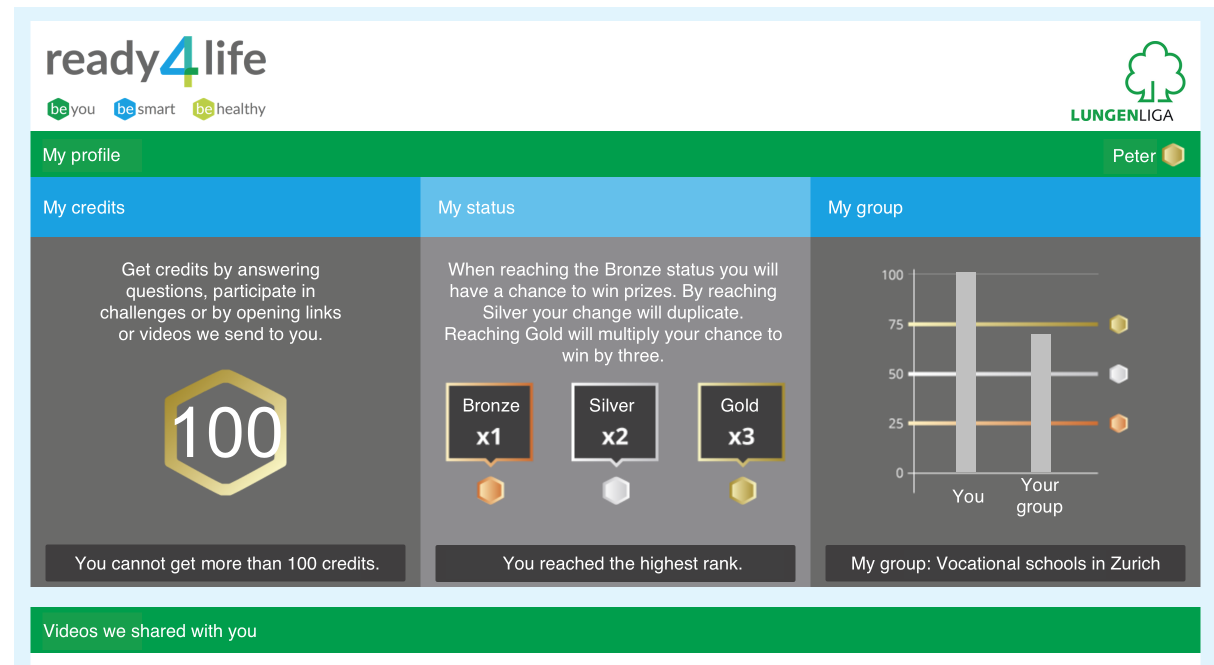
Figure 2. Individual profile page (translated from the German program